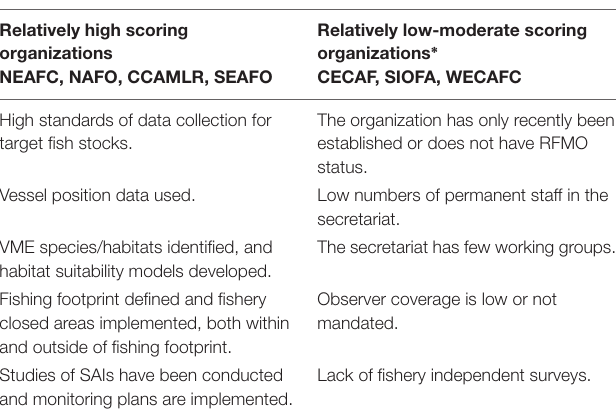
Relatively low-moderate scoring organizations ∗ CECAF, SIOFA,